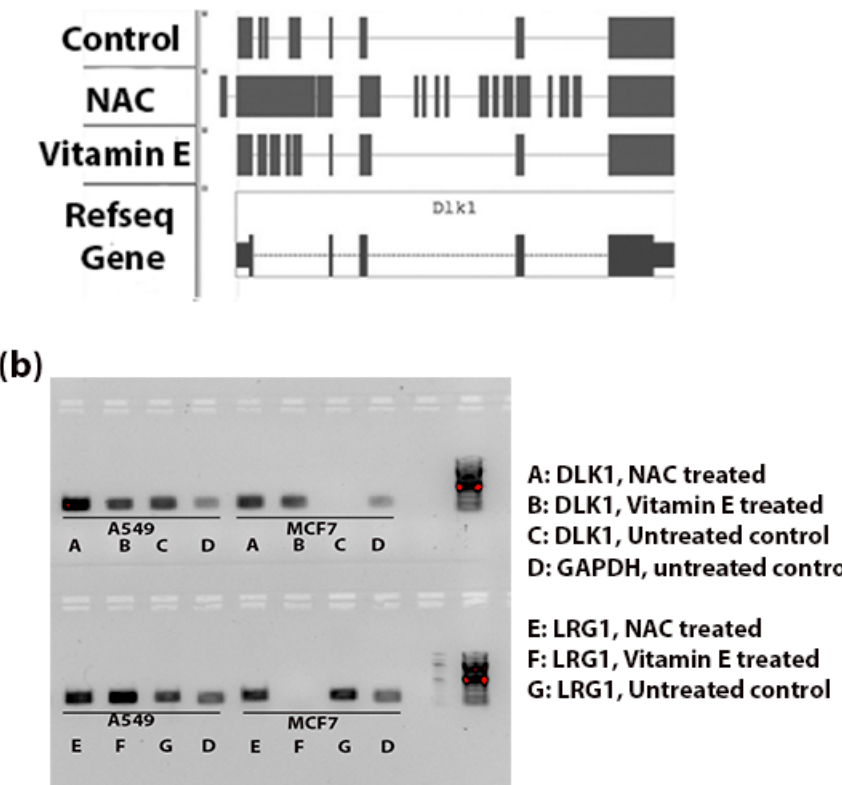
Figure 4. Intronic RNA expression of DLK1 and LRG1 ( a ) Schematic diagram to show the alignment of reads in the BAM files (Tophat output from the genomic alignment of RNA-seq data). Comparatively more reads are aligned to the intronic region (thin blue line) in the NAC-treated group than the control tumor and Vitamin E-treated groups. ( b ) RT-PCR validation of intronic RNA of DLK1 and LRG1 genes. Expression of introns of these two genes was observed in A549 and MCF7 cells. In A549 cells, NAC treatment seems to increase the expression of intronic RNA of DLK1; similarly the expression of introns of LRG1 was strong for the vitamin E treated A549 cells. No PCR amplification was observed with DLK1 intronic primers in the MCF7 control group and with LRG1 intronic primers in the MCF7 vitamin E treated group. The amplicon sizes of DLK1, LRG1 and GAPDH were 183 bp, 215 bp and 173 bp,